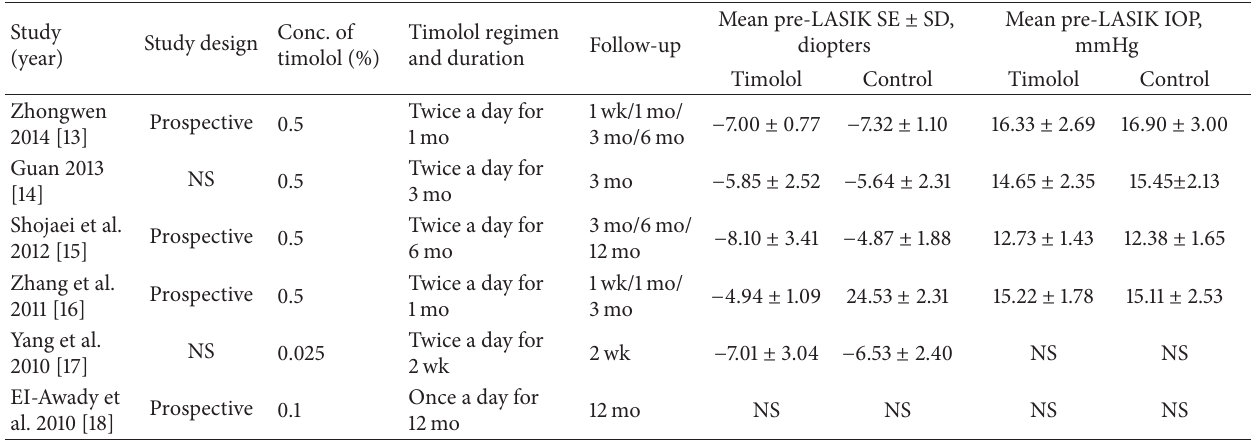
Table 2: Clinical characteristics of eligible